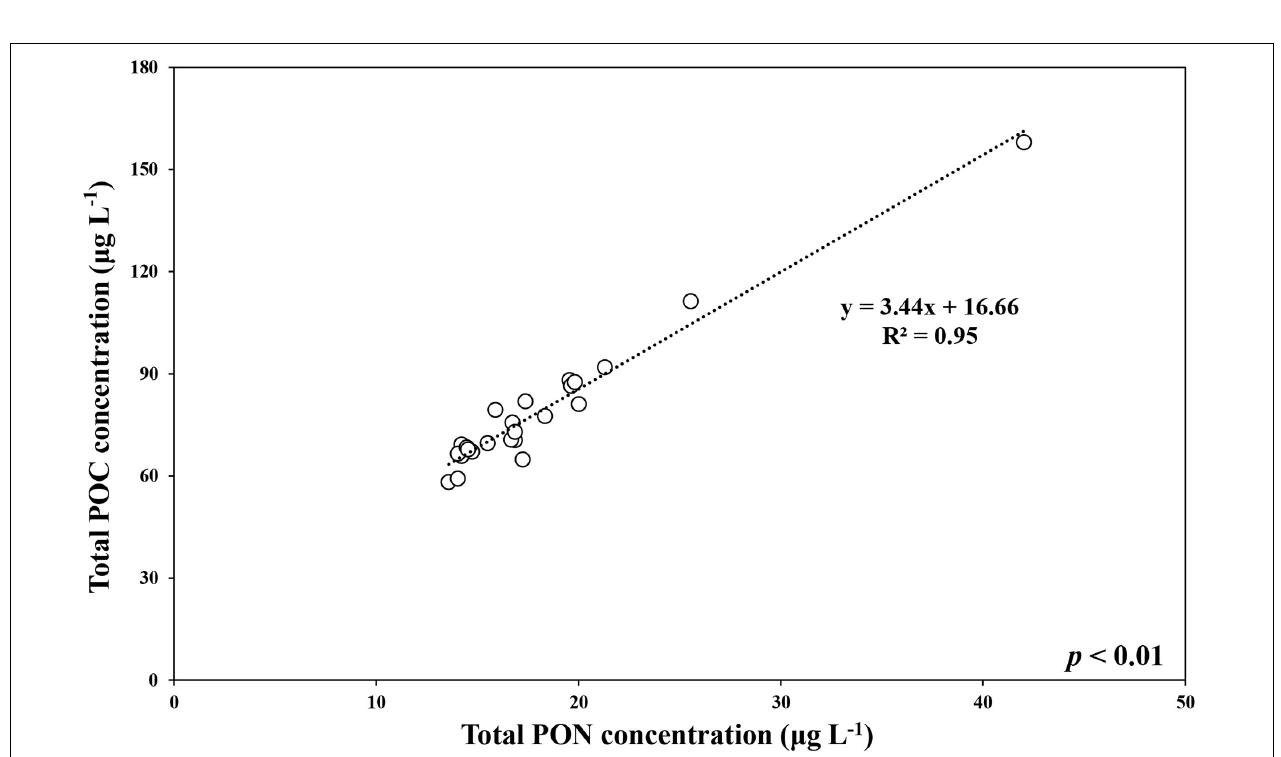
FIGURE 3 | The relationship between total POC and total PON concentrations at JBS during the ice-covered period, 2015.